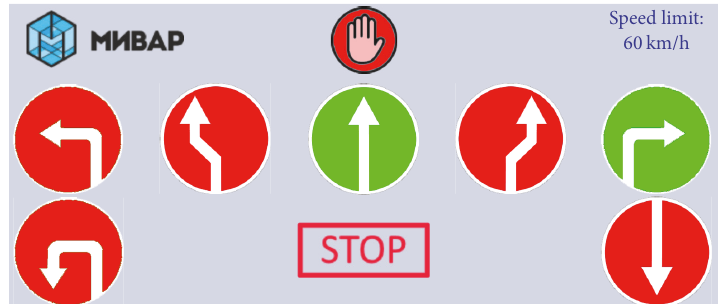
Figure 6: Dashboard interface with resulting AI data (10